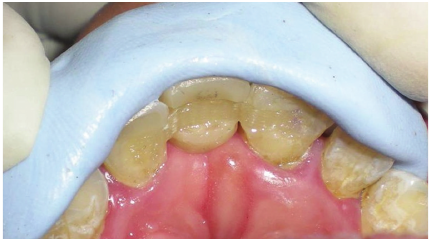
Figure 4: Fiber reinforced composite resin placed in slots after stabilization of pontic with putty index.